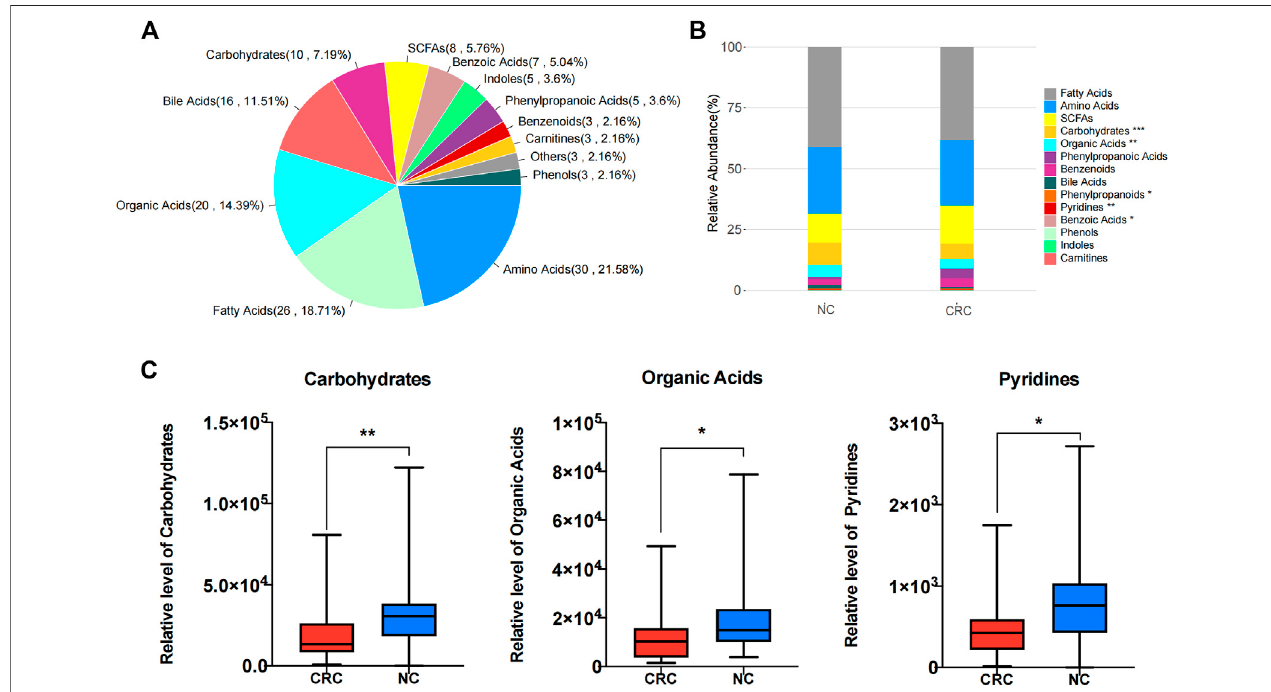
FIGURE 3 | Metabolomic signature of fecal samples from CRC and NC groups. (A) Pie chart illustrating the abundance ratio of different classes of metabolites detectedbytargetedmetabolicpro fi linginfecalsamplesfromCRCpatientsandNCcontrols. (B) Stackedbarplotshowingtherelativeabundanceofdifferentclassesof metabolites in both the control CRC and NC groups. * p < 0.05, ** p < 0.01, *** p < 0.001. (C) Aggregate values for metabolite categories from CRC patients and NC controls. * p < 0.05, ** p <